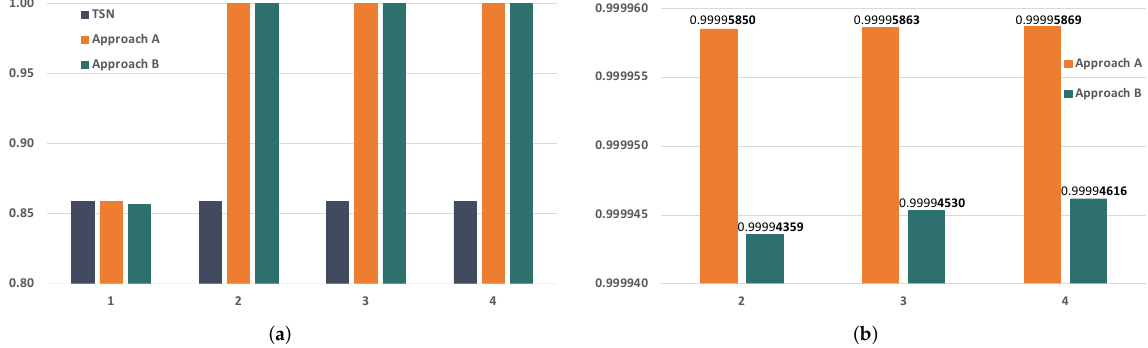
Figure 13. Reliability achievable when varying the number of replicas in a network with a BER of 1 × 10 − 10 . TSN is represented in grey, approach A in orange and approach B in green. The x axis represents the number of replicas, while the y axis represents the reliability. ( a ) Reliability achievable by TSN, approach A and approach B when varying the number of replicas. In TSN the number of replicas is always 1. ( b ) Zoom in the reliability achievable by approach A and approach B when varying the number of